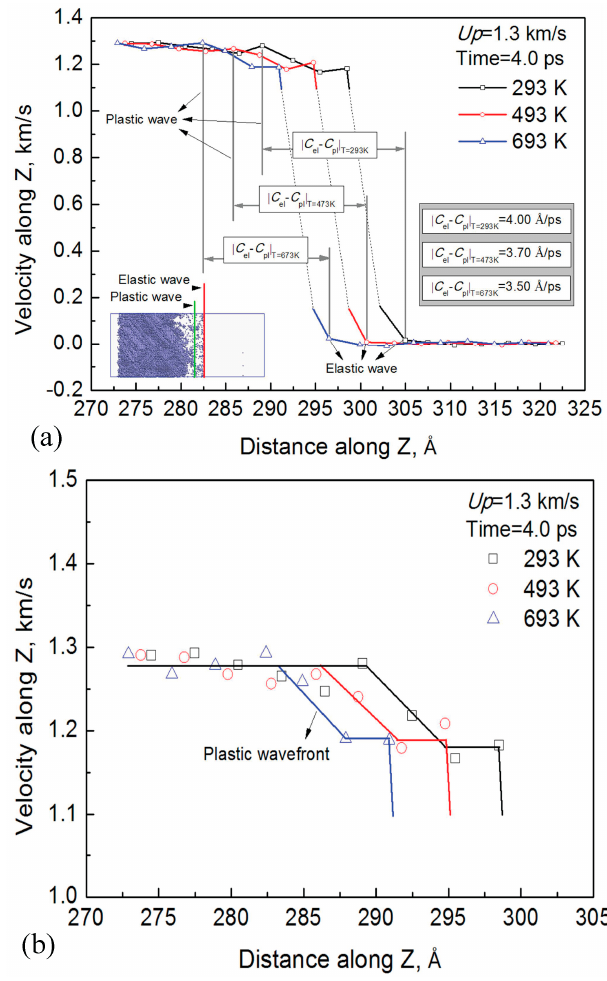
Figure 6. Elastic and plastic waves induced by the LSW in the [001] direction. ( b ) is the local magnification of ( a ).